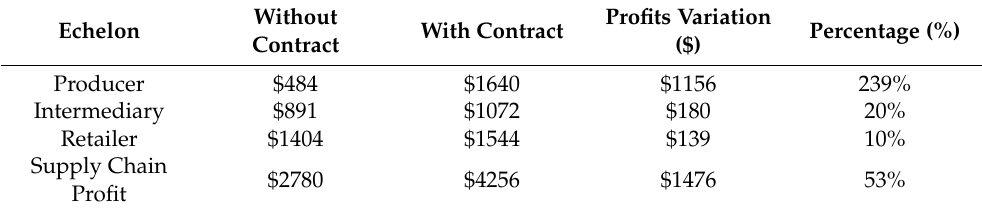
Table 2. Profits with and without backup agreement. (Source: